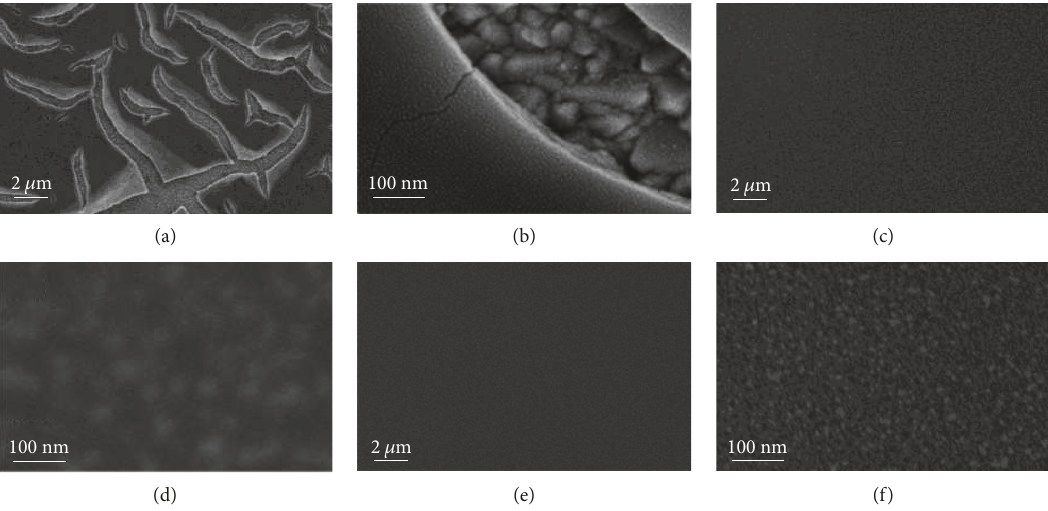
fi lm with di ff erent spin coating speeds for 60s. (a), (c), and (e) the low magni fi cation and (b), Figure 2: Top view SEM images of c-TiO 2 (d), and (f) the high magni fi cation images for 1000rpm, 2000rpm, and 3000 rpm,